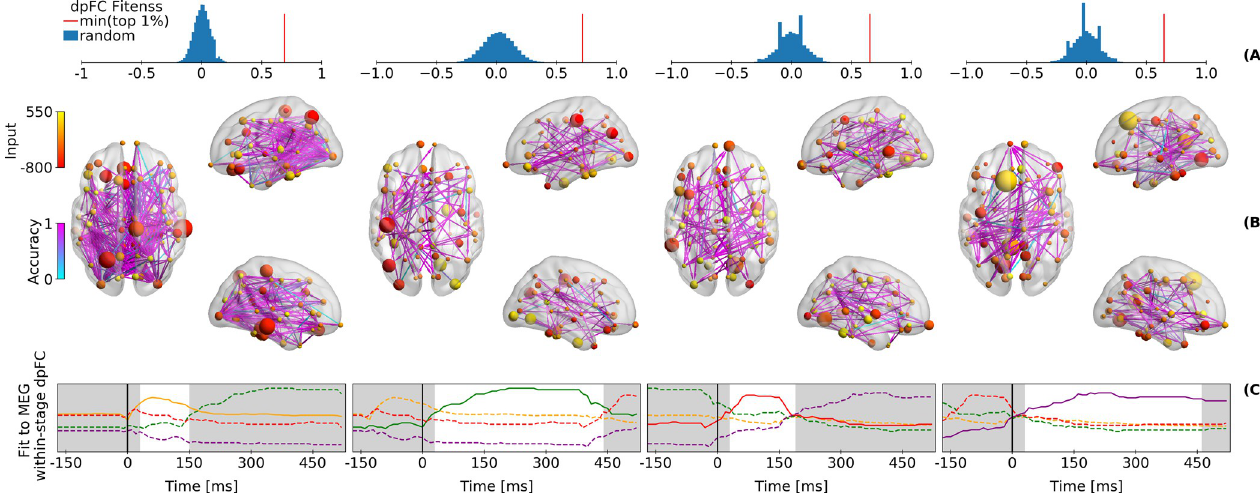
Fig 2. Simulated directed functional connectivity. (A) Blue histograms show the fitness between 20,000 randomly generated within-stage dpFCs and the MEG within-stage dpFC . The red line indicates the within-stage dpFCs fitness of the model with the lowest fitness index within the top 1 percentile of the optimized models. (B) Fitness of simulated-to-MEG within-stage dpFC is shown in cyan-purple grading over MEG links with significant within-stage dpFC (same as Fig 1B). The nodes indicate the relevance of a region for reaching a state of within-stage dpFC (size), and the pulse of local connectivity strength at the onset of the stage due to sub-cortical inputs (colors). See S4 Fig for the standard error of the means. These results show the averages of 1000 random picks from top ~1% of the optimizations with the best fitness index. (C) Temporal evolution of simulated-to-MEG fitness of within-stage dpFC for the current stages (solid lines) compared to other stages (dashed). The white background spans the median stage duration. The colors of the lines represent the different stages and follows Fig 1C.